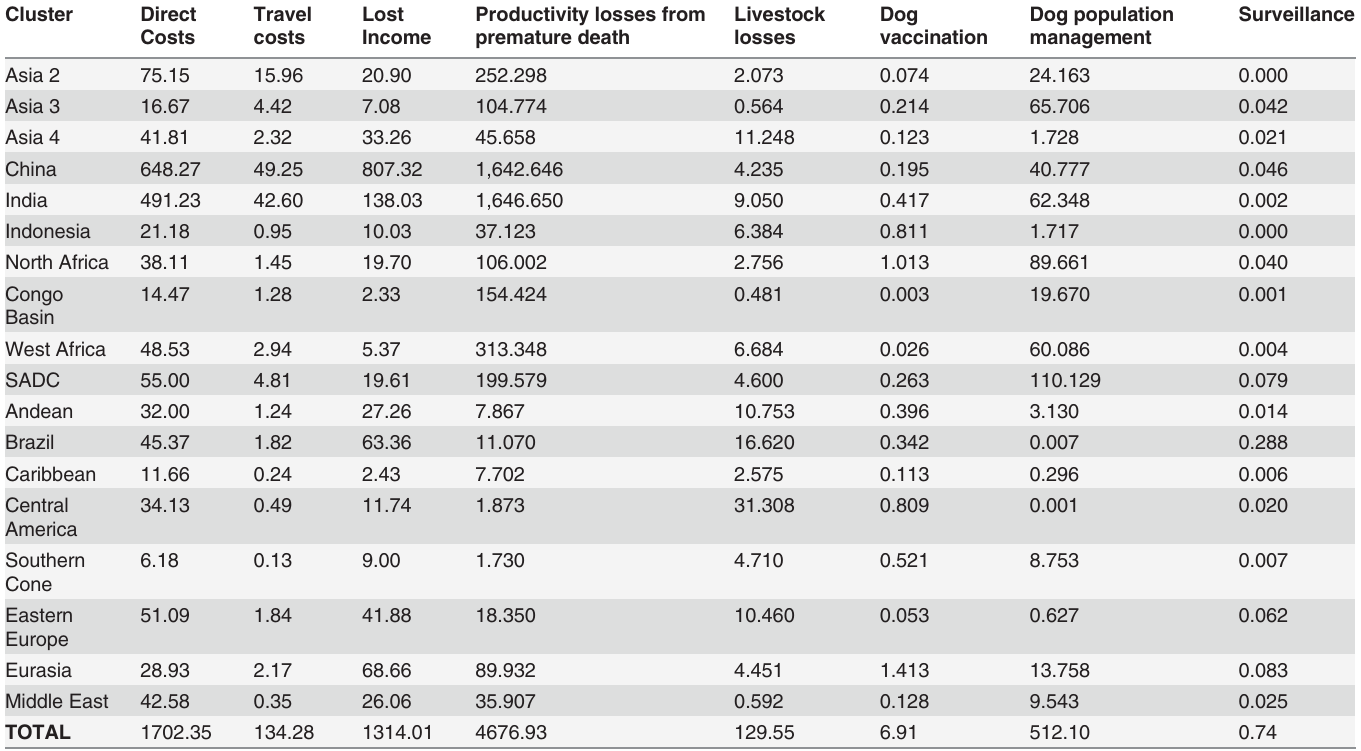
Table 3. Breakdown of economic costs of rabies by cluster in thousands of USD.